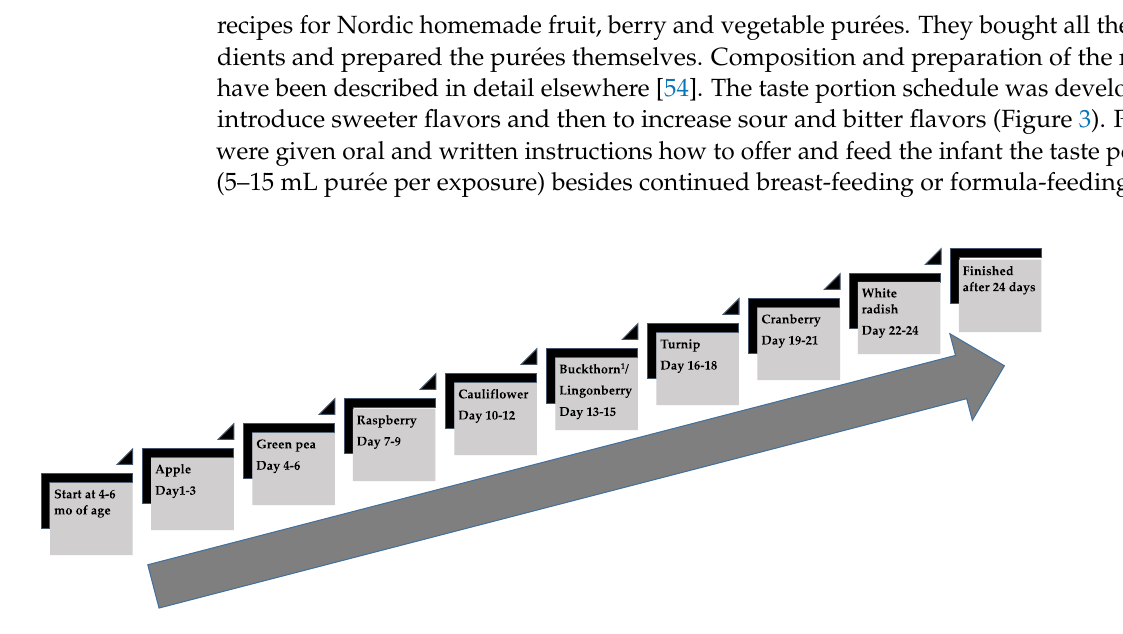
Figure 3. The taste portion schedule with the repeated exposures of fruits and vegetables in the Nordic group from 4 to 6 mo of age. Three exposures per day during three consecutive days per each fruit/berry or vegetable purée, in total 72 exposures during 24 days. 1 Buckthorn berry, a seasonal product was replaced by lingonberry when shortage appeared.